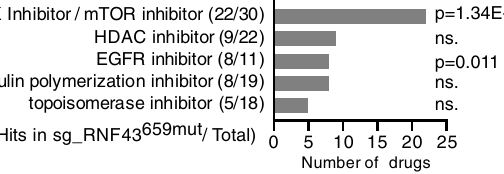
Fig. 2 Repurposing library screening to identify compounds targeting RNF43 _659fs. A Flowchart of Repurposing Library compound screening and selection criteria for candidate drug identi fi cation. B Quanti fi cation of selective inhibition of library compounds in HT29 (top), and validation of PI3K/mTOR inhibitor compounds in LS513 RNF43 659mut edited cells and HCT116 RNF43 G 659fs overexpressing (OE) cells (bottom). Red data points indicate PI3K/mTOR inhibitors. C Pathway enrichment analysis of repurposing library compound screening in the initial screening population of HT29 RNF43 659mut with a Z value less than − 3 (top, among 612 signi fi cant drugs) and compounds that had >5% killing between HT29 RNF43 659mut and HT29 ctrl (bottom, among 221 signi fi cant drugs). Two-sided Pearson ’ s χ 2 test. D Venn diagram illustration of PI3K/mTOR signi fi cant candidate compound overlap (red) in HT29, LS513 RNF43 659mut edited cells and HCT116 RNF43 659mut overexpressing cells with n the number of compounds from the primary screen that validated in the secondary screen for each cell line. Source data are provided as a Source Data fi